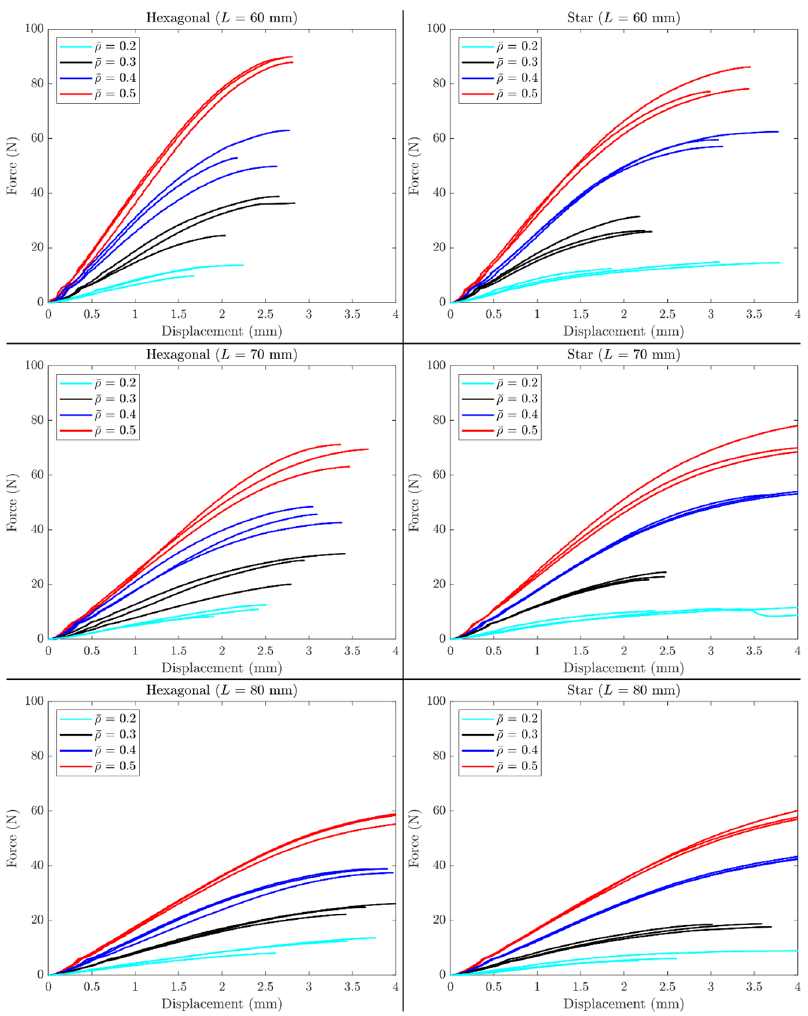
Figure 5. Load-deflection curves for hexagonal structure ( right ), and star ( left ).